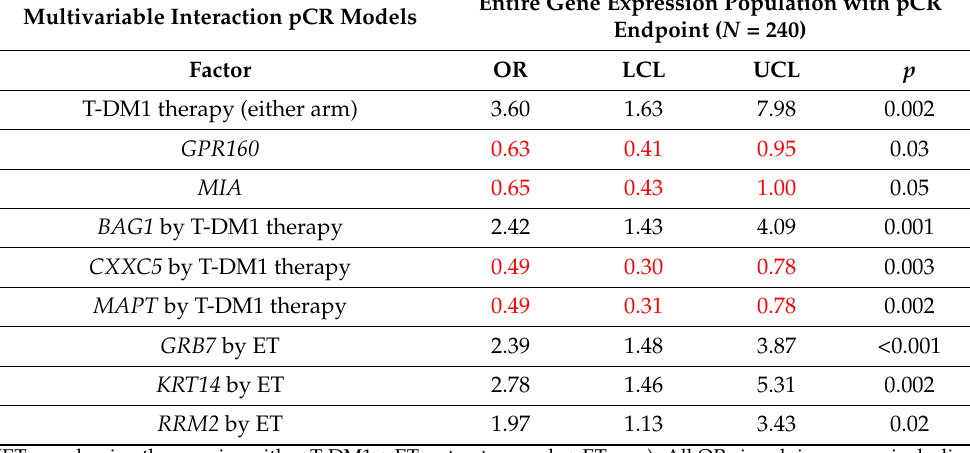
Table 6. Multivariable logistic regression models to predict pCR including therapy, all genes (RNA- expression) with significant impact analyzed, and all gene-therapy interactions. Multivariable Interaction pCR